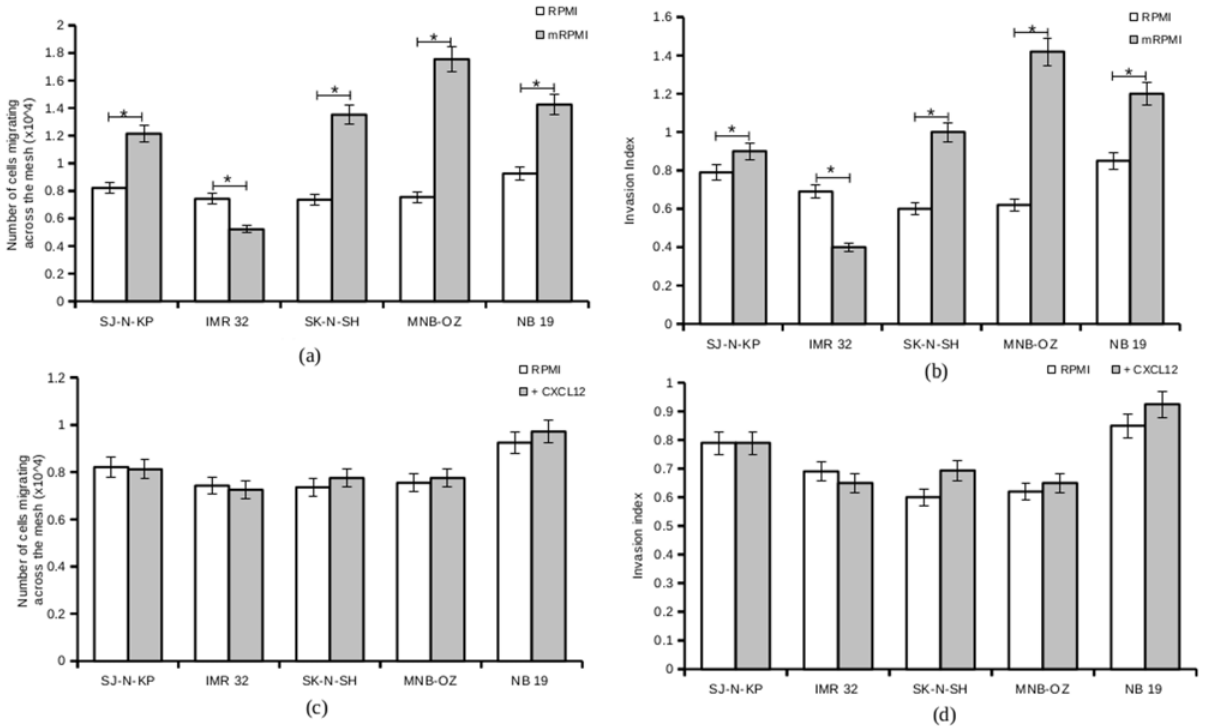
Fig 7. Effect of CXCL12 and mRPMI on invasion in neuroblastoma cells. a. Neuroblastoma cells serum-starved (control) and pre-treated with CXCL12, were assayed for invasive potential using transwell invasion assays. Plotted is the mean number of cells migrating across the mesh from 5 experiments. b. Invasion index of neuroblastoma cell lines serum-starved (control) and pretreated with CXCL12. Plotted is the invasion index calculated from 5 experiments. c. Neuroblastoma cells serum-starved (control) and pre-treated with mRPMI, were assayed for invasive potential using transwell invasion assays. Plotted is the mean number of cells migrating across the mesh from 5 experiments. ( * p < 0.05) d. Invasion index of neuroblastoma cell lines serum-starved (control) and pretreated with mRPMI. Plotted is the invasion index calculated from 5 experiments. ( * p < 0.05)